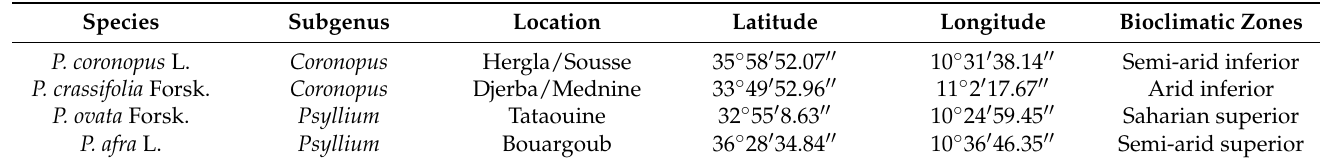
Table 3. Origin and bioclimatic zones of the studied Plantago